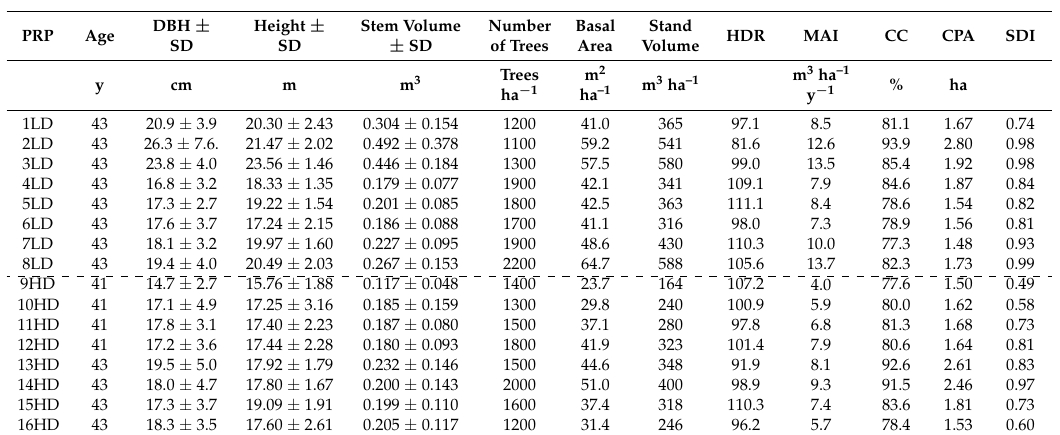
Table 2. Stand characteristics of the tree layer on permanent research plots 1–16 in 2017 (LD—plots with low game damage; and HD—plots with high game